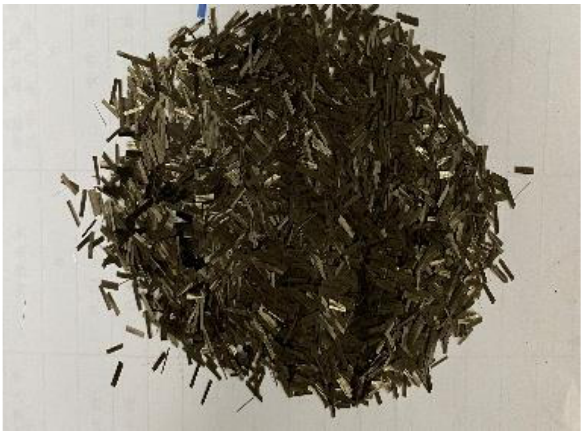
Figure 1. Basalt fiber. Table 1. The properties of basalt fiber.